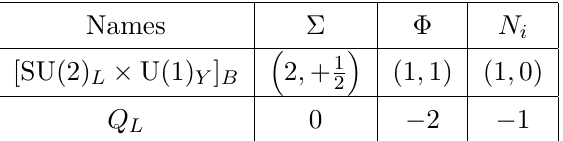
Table 3 . Additional twin fields shown for model described in section 3.2. (Related SM fields not shown.)